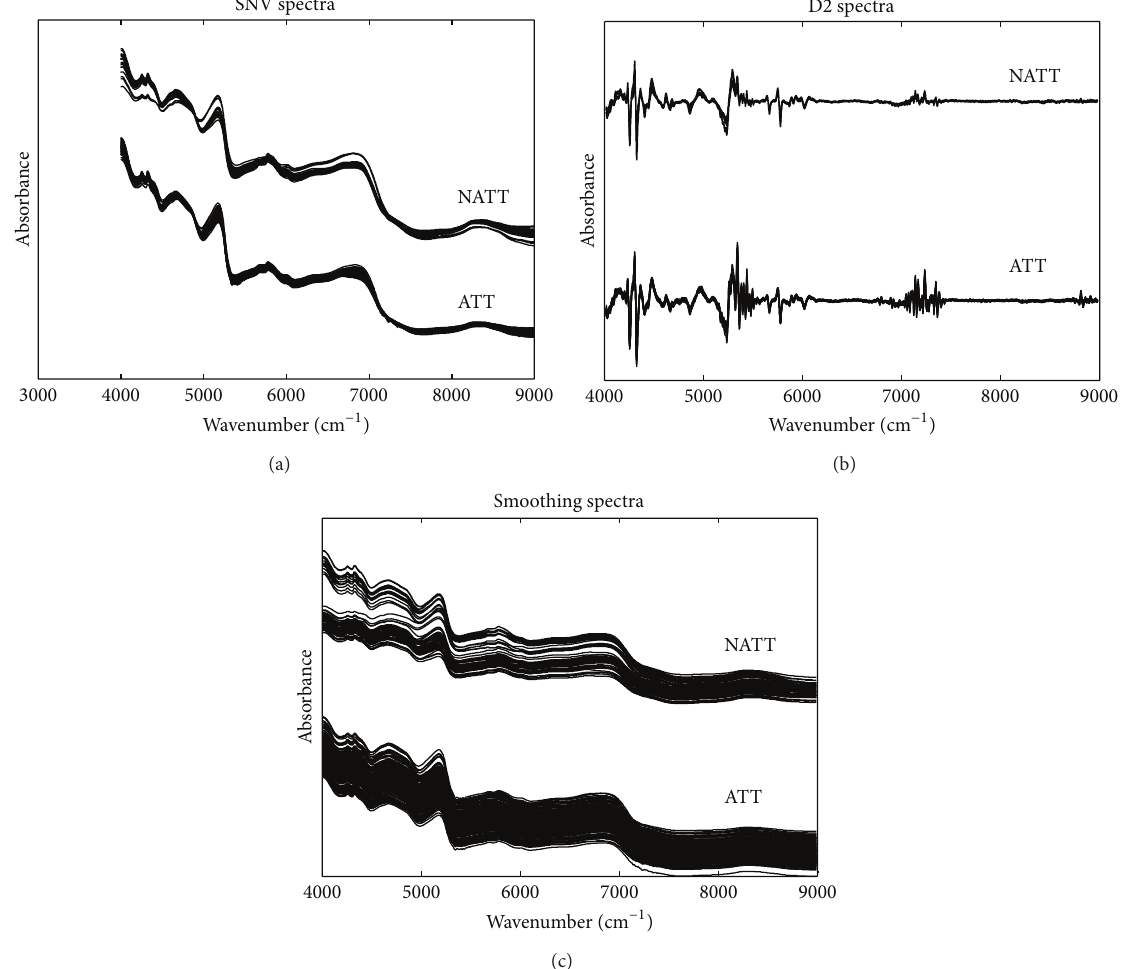
Figure 3: NIR spectra of samples preprocessed by SNV (a), D2 (b), and smoothing (c); an artificial shift was added to distinguish ATT and